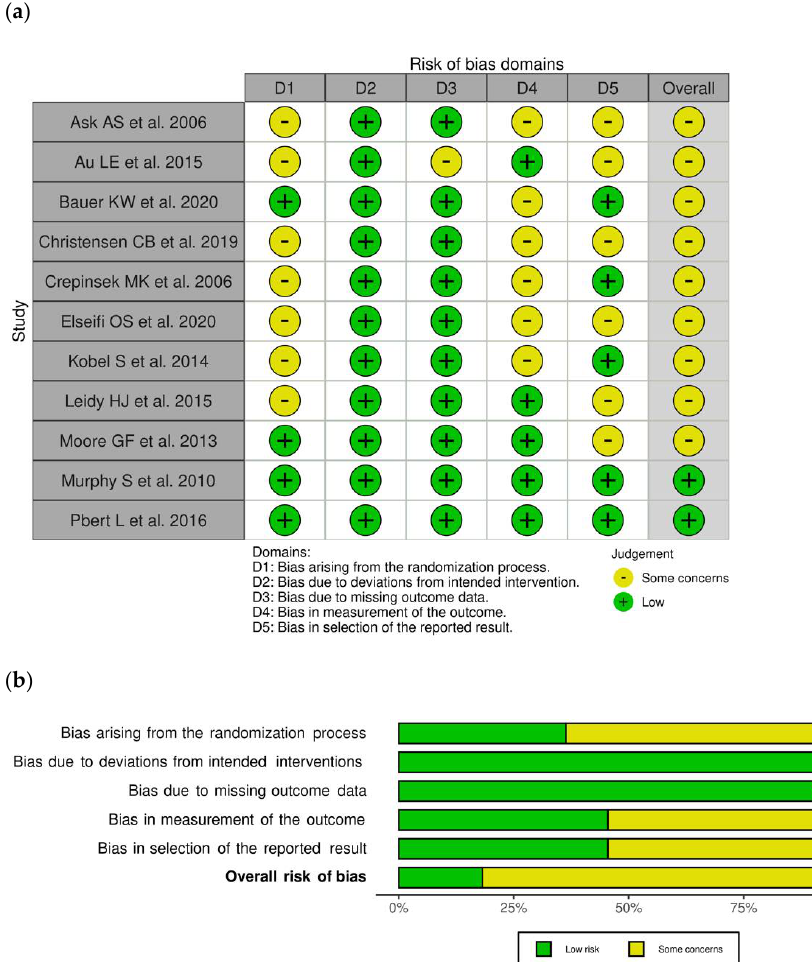
Figure 3. Risk of bias within RCTs. ( a ) Traffic light plot and ( b ) summary plot presenting the risk of bias within the RCTs included in the systematic review.